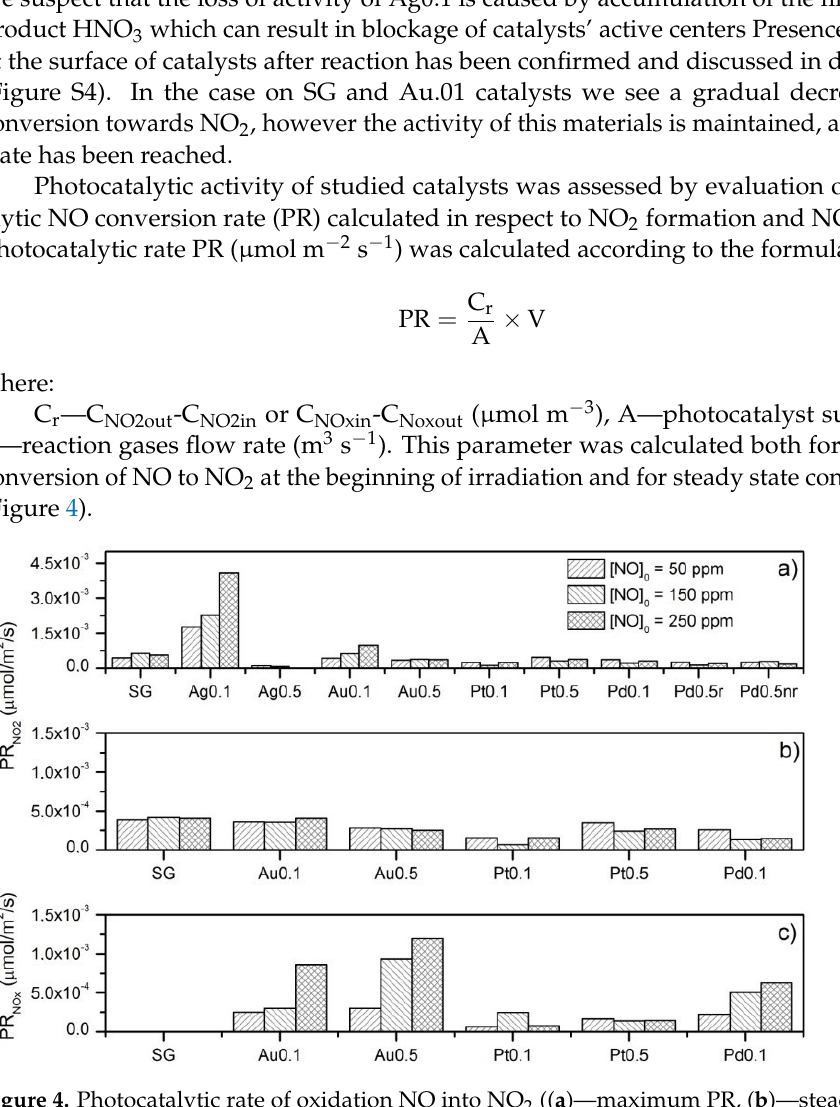
Figure 4. Photocatalytic rate of oxidation NO into NO 2 (( a )—maximum PR, ( b )—steady state PR), ( c )—photocatalytic rate of NO x removal. ( c )—photocatalytic rate of NO x